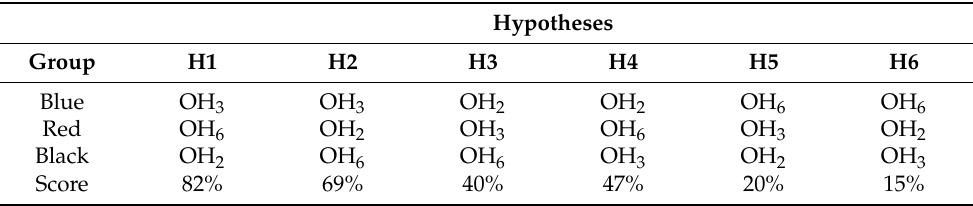
Table 1. Score (%) obtained with the comparison of CCS exp and CCS th for the assignment hypotheses of the grafted position on β CD. The blue, red and black colors correspond to the group of regioisomers defined by MS/MS